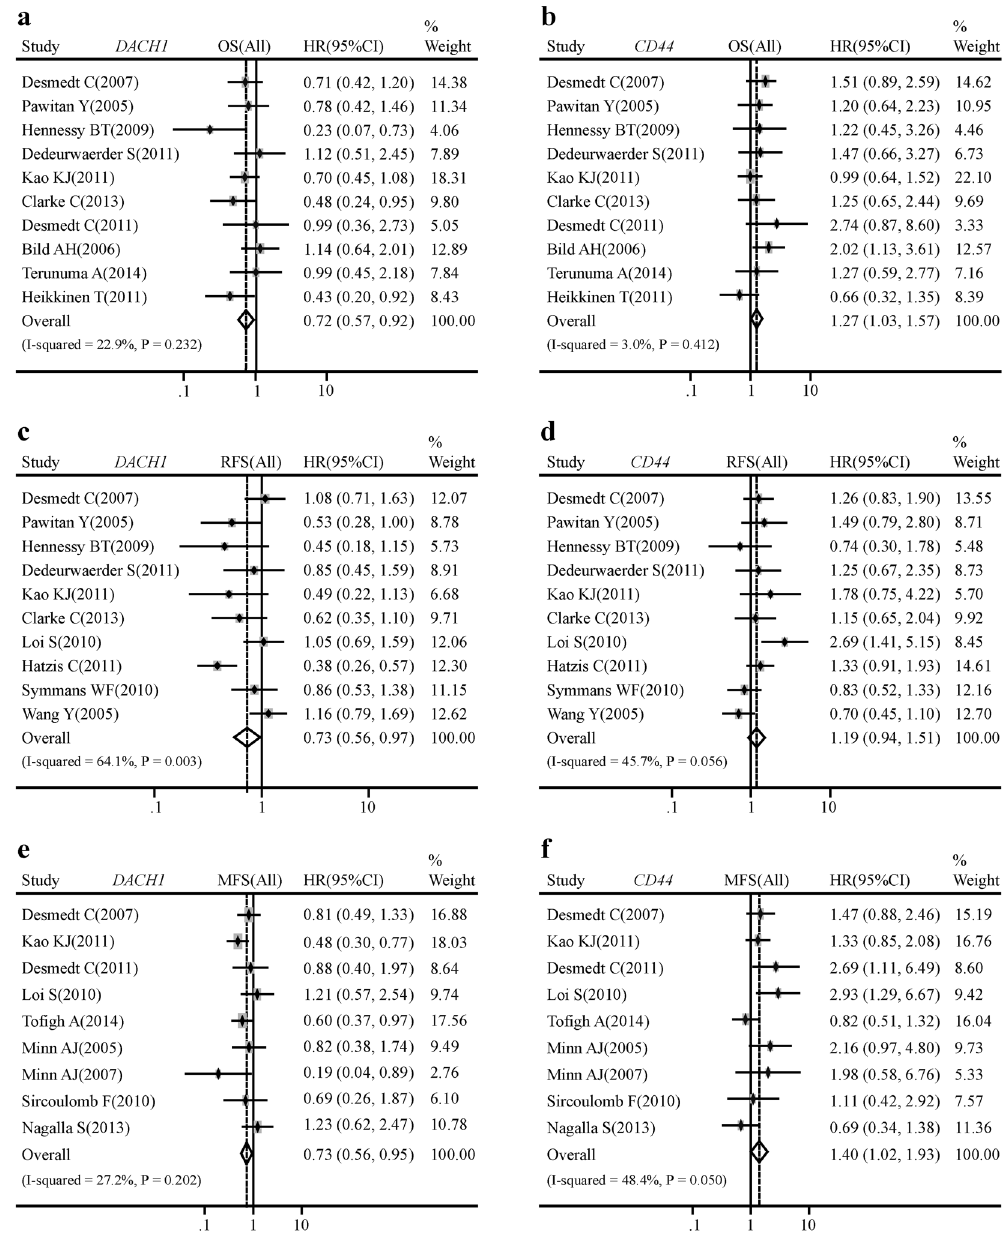
Figure 7. DACH1 and CD44 were related to clinical outcomes of breast cancer patients. Meta-analysis of a total of 19 public databases showed that breast cancer patients with higher DACH1 mRNA level tended to have better overall survival ( a ), relapse-free survival ( c ), metastasis-free survival ( e ). On the contrary, patients with higher CD44 mRNA expression had shorter time to death ( b ) and metastasis ( f ), but did not acquire statistically significant worse relapse-free survival in comparison to patients with comparatively lower CD44 expression ( d